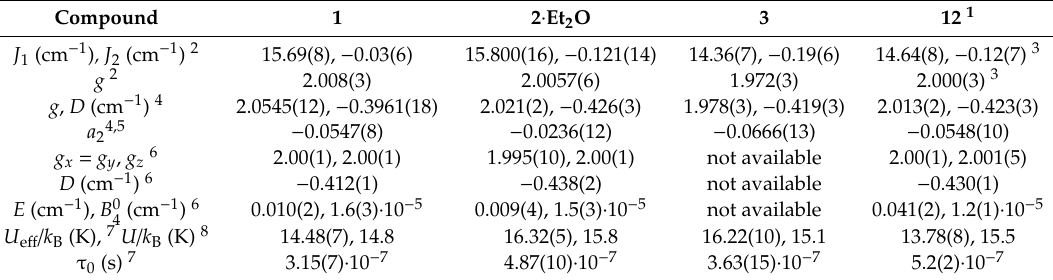
Table 1. Magnetic parameters for 1 , 2 · Et 2 O, 3, and 12